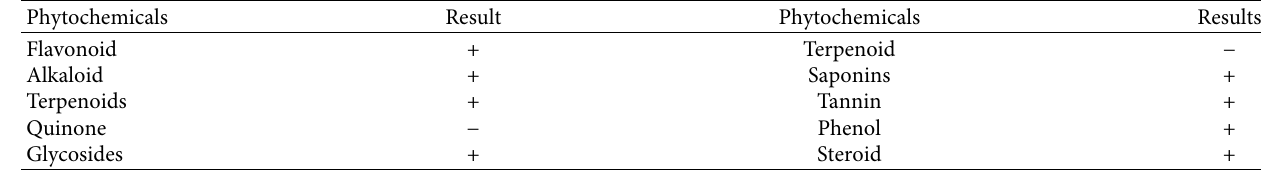
Table 2: The preliminary phytochemical screening of ethanolic extract of the root of A . africanus .